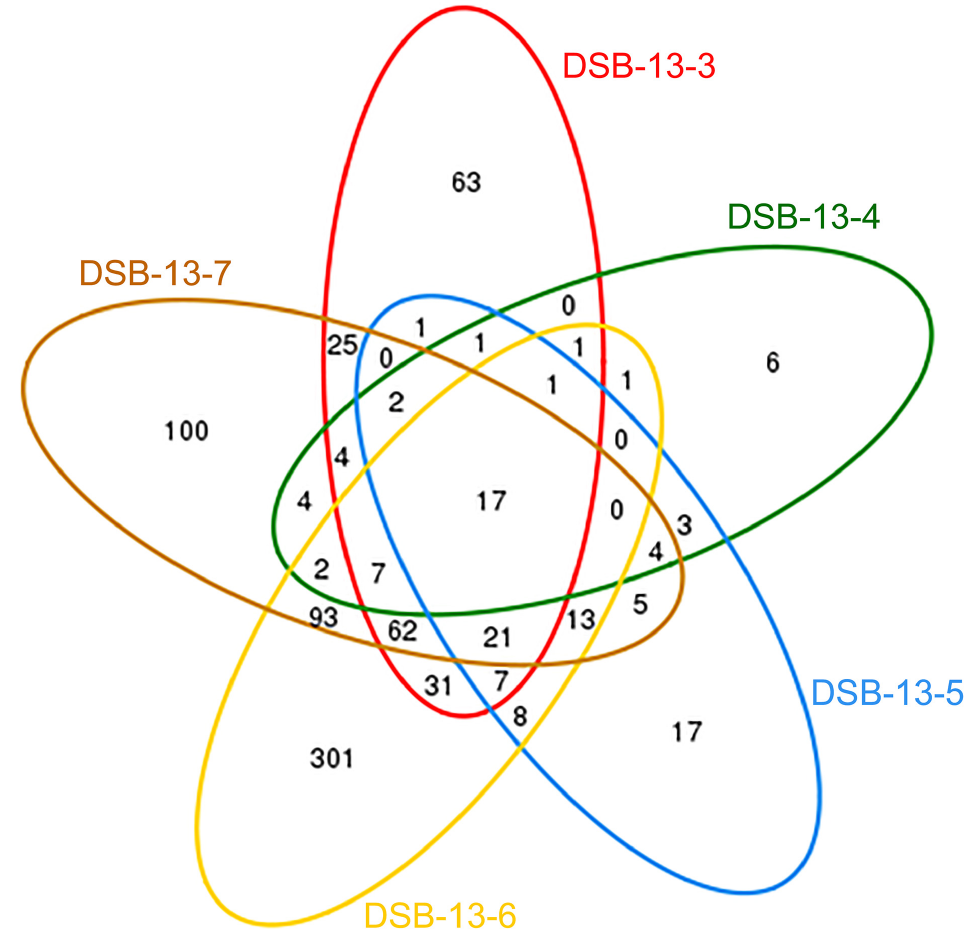
Figure 6. Venn diagram of abalone intestine samples in different months. Sample names: Subgroup name–year–month.